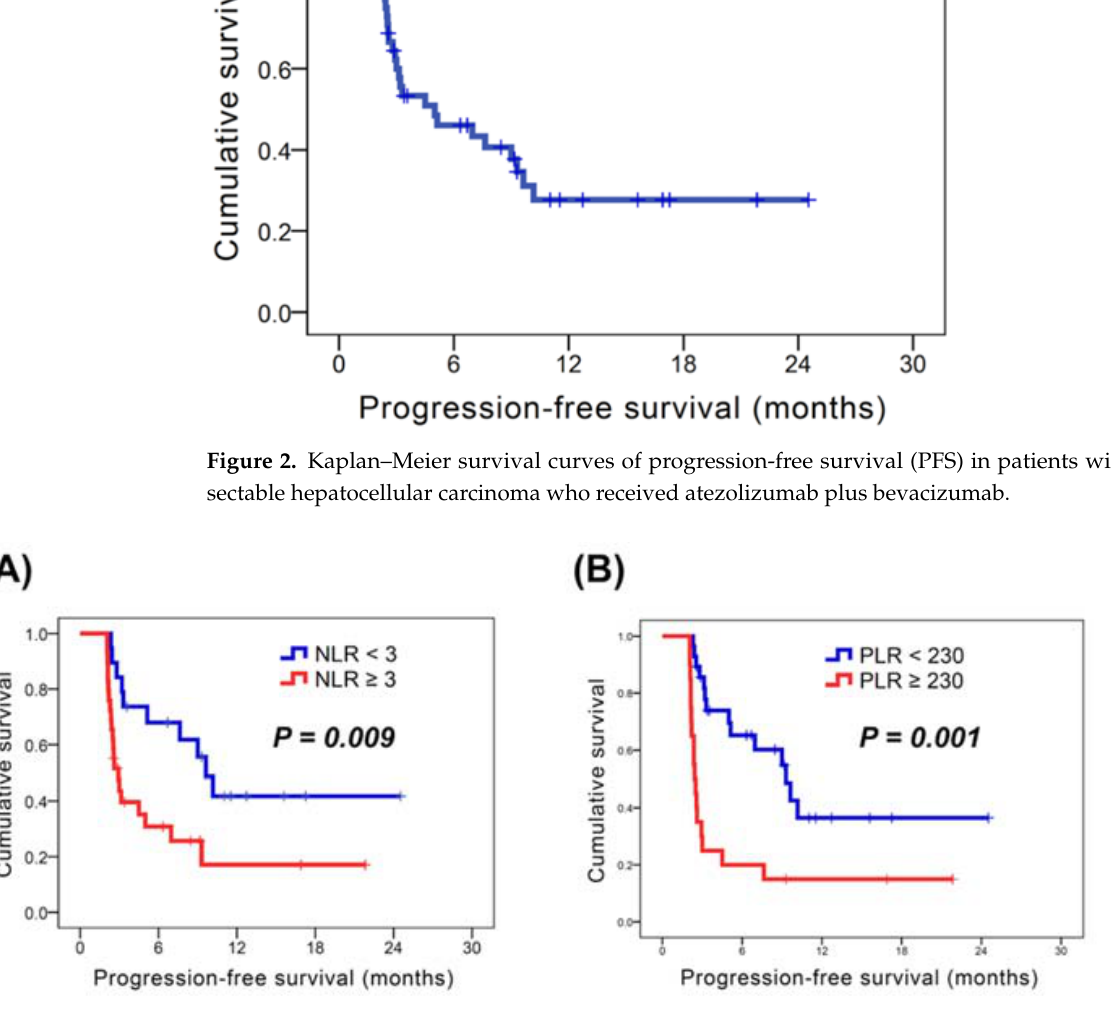
Table 3. Univariate and multivariate analyses of progression ‐ free survival (PFS) in 48 patients with unresectable hepatocellular carcinoma who received atezolizumab plus bevacizumab.